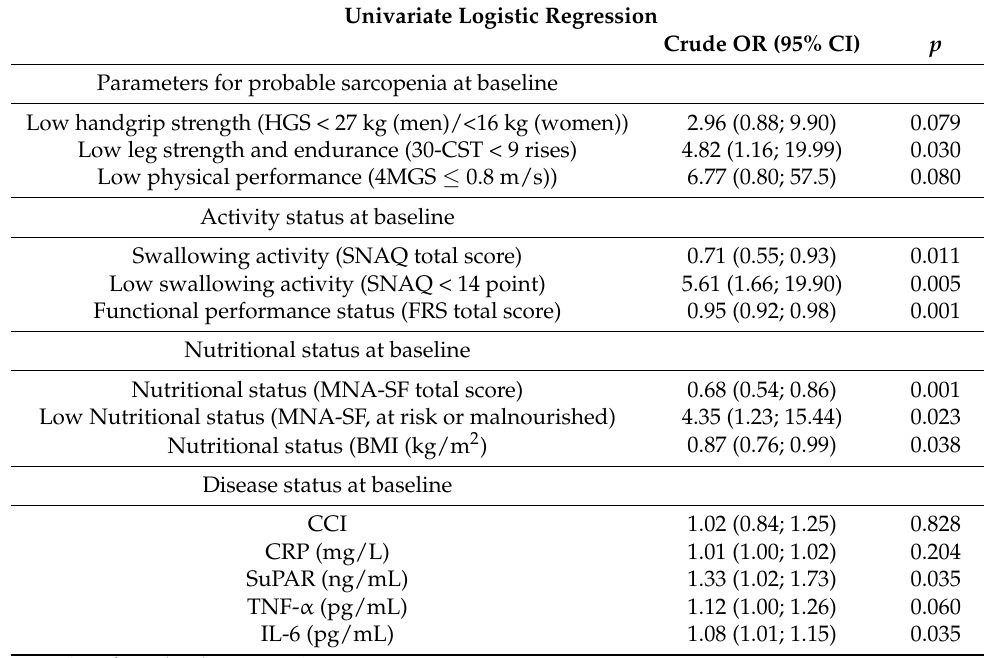
Table 4. Associations of signs of dysphagia at 56-week follow-up and baseline status. Univariate Logistic